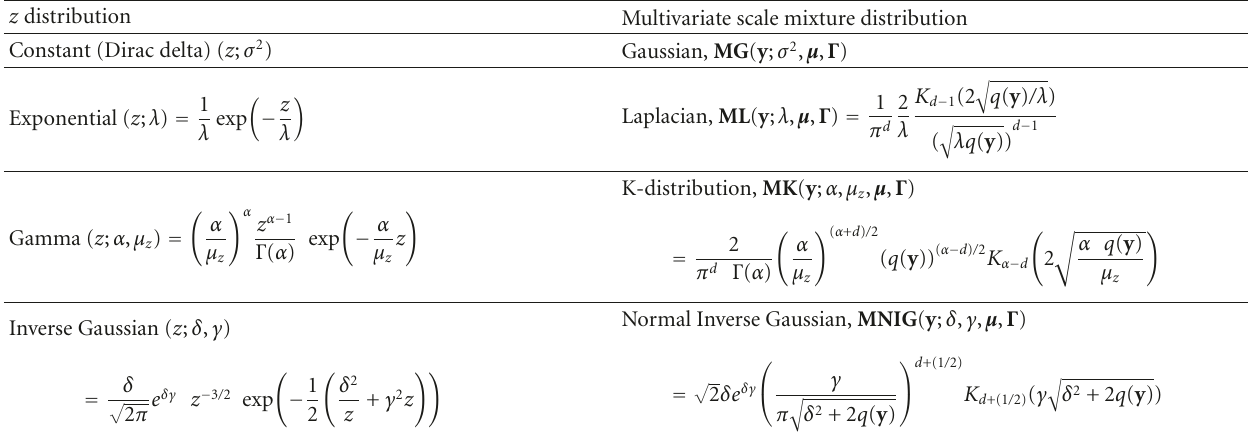
Table 1: Scale mixture of Gaussian models.